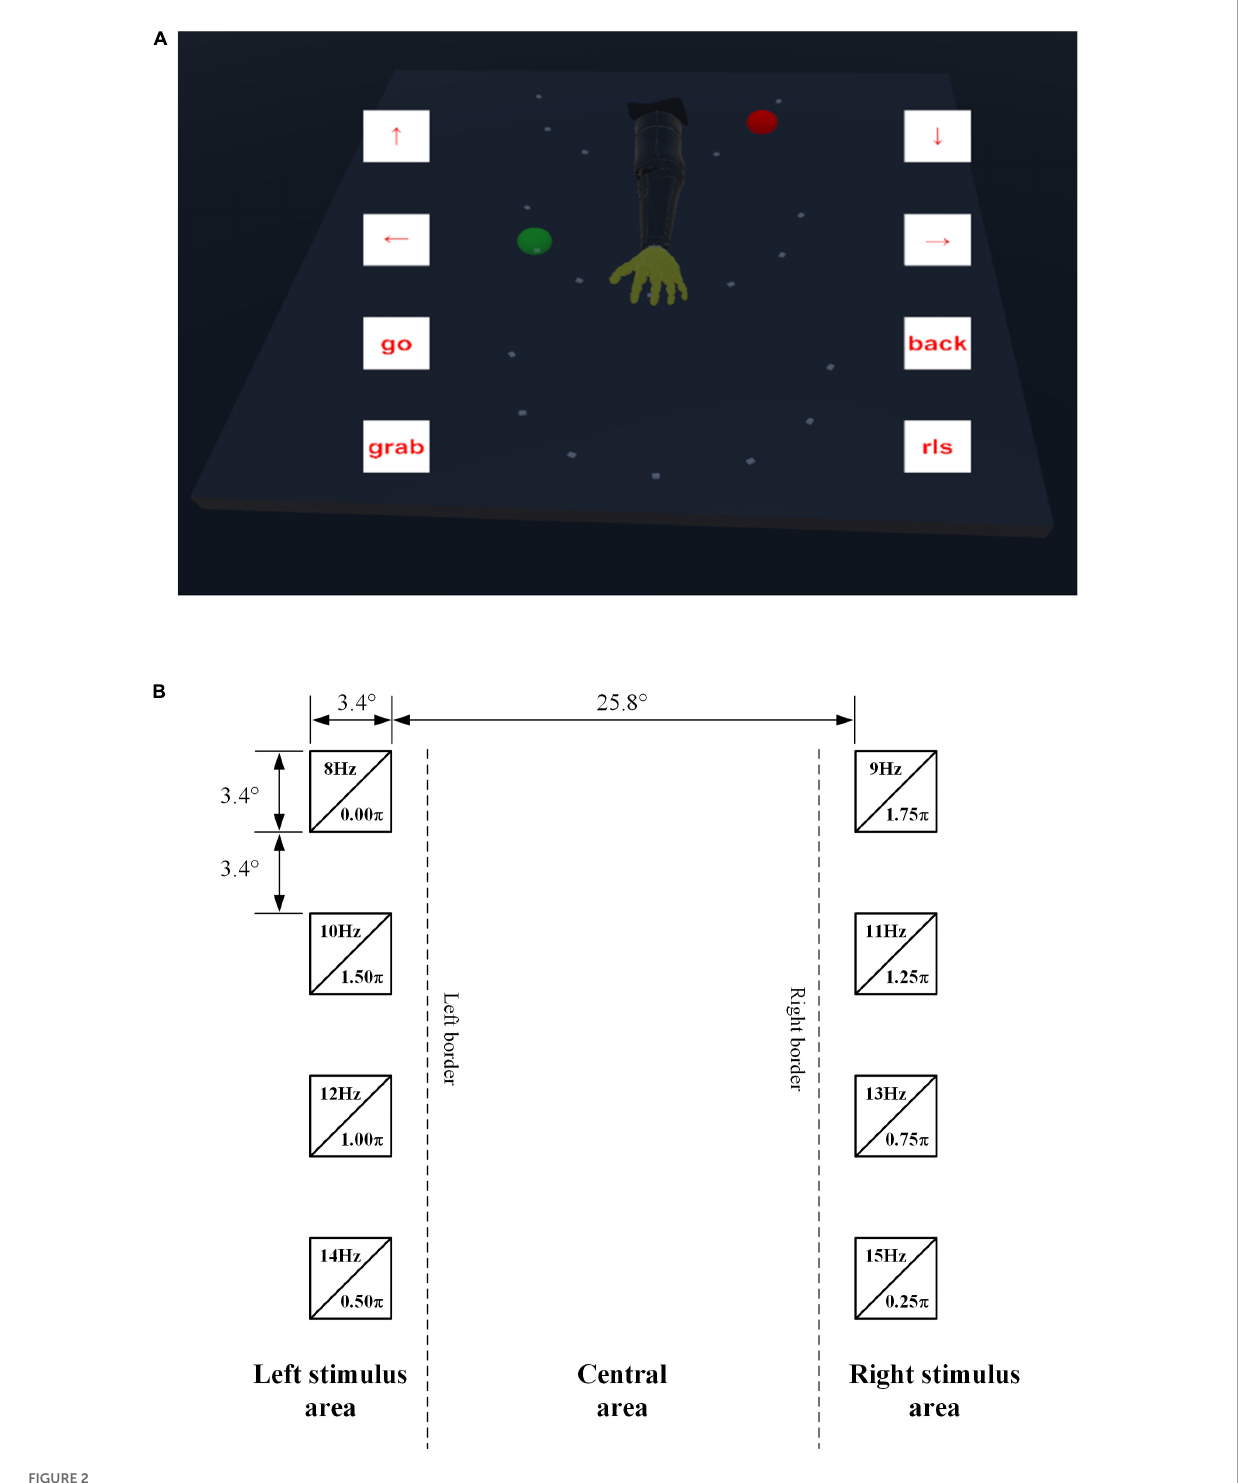
Considering the contribution of high-order harmonics with high SNR in SSVEP data to target classification, the FBCCA (Chen et al., 2015a) algorithm was used to classify SSVEP data in this study. This algorithm first used a filter bank to decompose the preprocessed EEG data into multiple sub-band components. Then